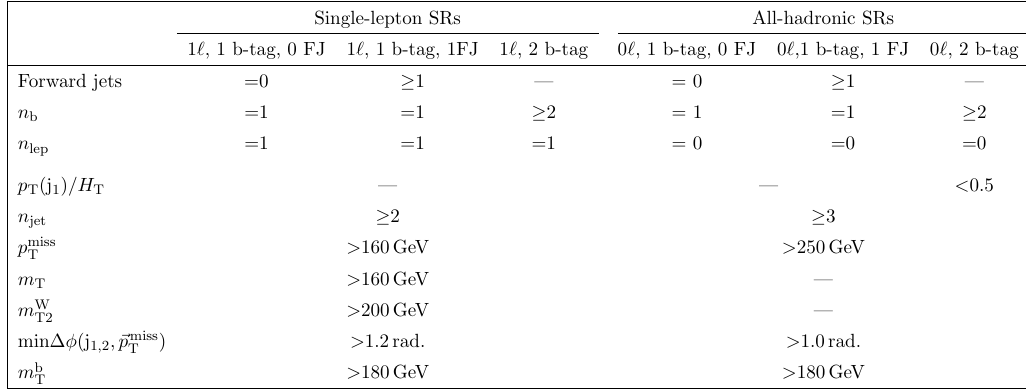
Table 1 . Final event selections for the SL and AH SRs. Electrons and muons are kept separate for the SL